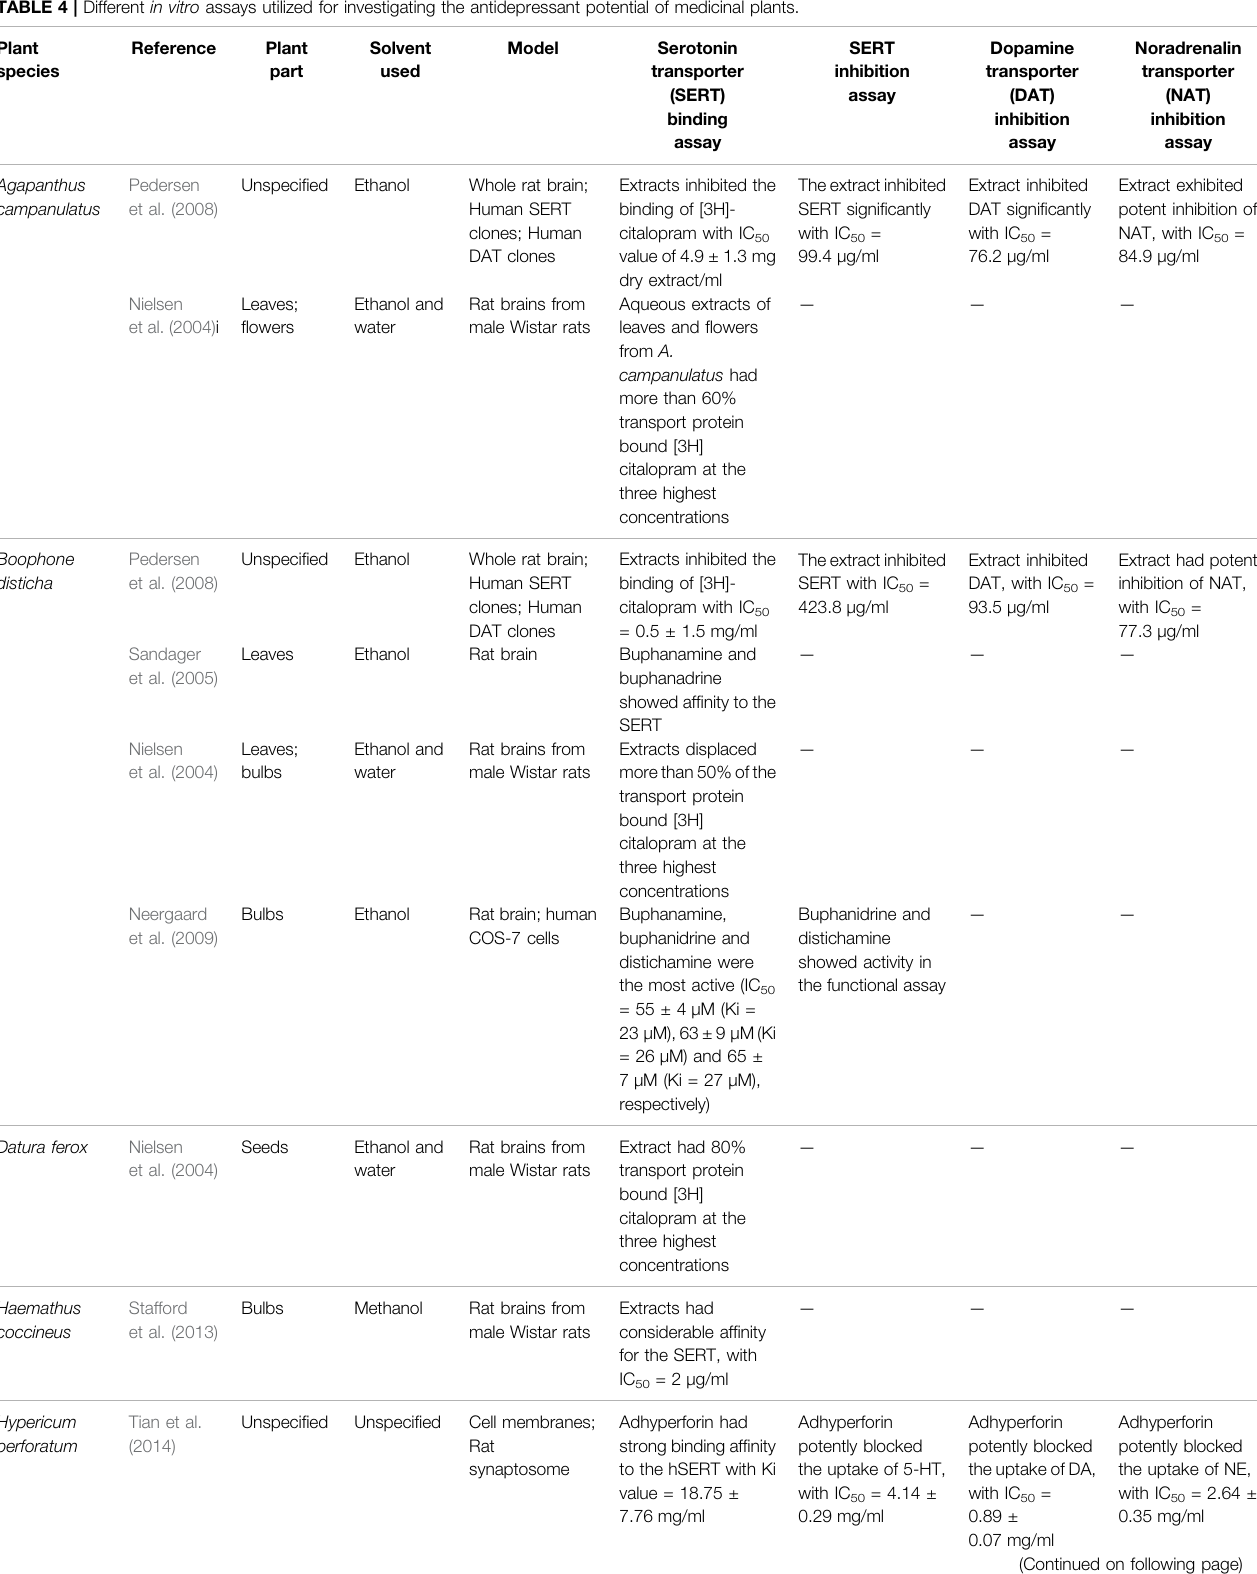
TABLE 4 | Different in vitro assays utilized for investigating the antidepressant potential of medicinal plants. Plant